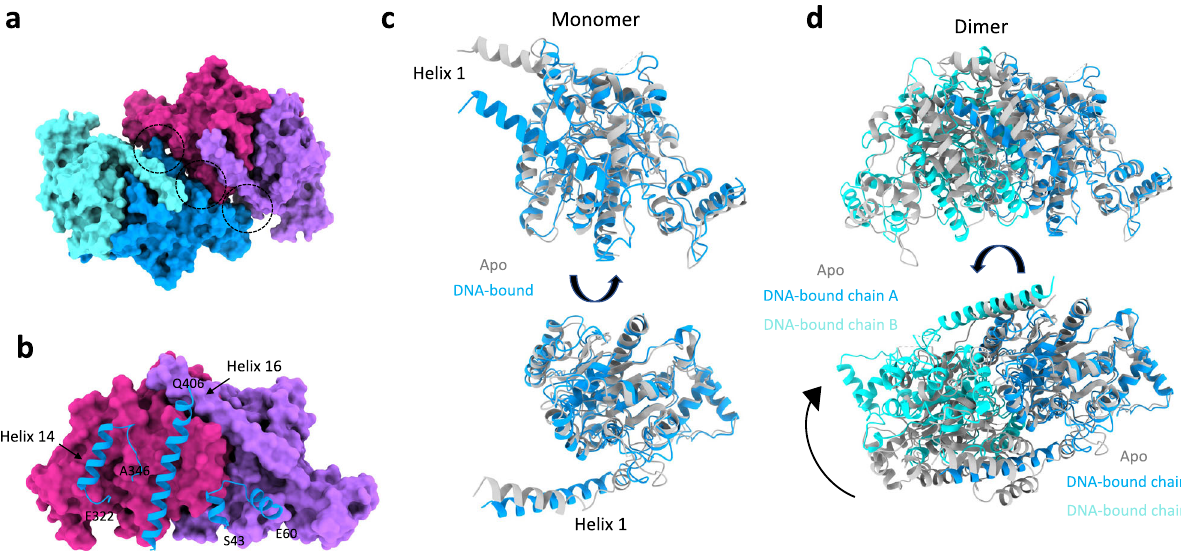
Fig. 5 ParA2 vc fi lament interfaces, and structural changes upon fi lamentation. a Surface representation of two adjacent ParA2 vc dimers in the fi lament structure, colored as in Fig. 3c. The interacting regions are indicated with black dotted circles. b One dimer from a is shown in surface representation, and the regions of the second dimer that are involved in the interaction are shown in cartoon. The residue boundaries are indicated. c , d Comparison between the ParA2 vc structure in the free (grey) and DNA-bound (blue/cyan) conformations. A monomer is shown in c , illustrating the rearrangement of helix 1; and a dimer is shown in d , aligned on the blue subunit, to show the dramatic change in the dimer